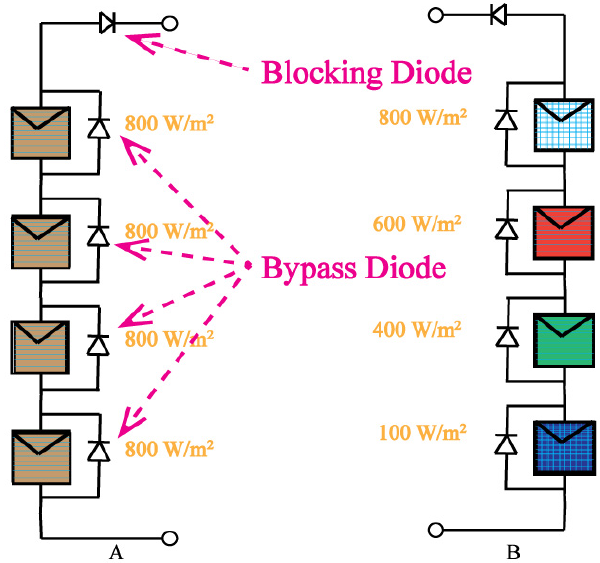
Figure 3. ( A ) Uniform irradiance case. ( B ) Partial shading